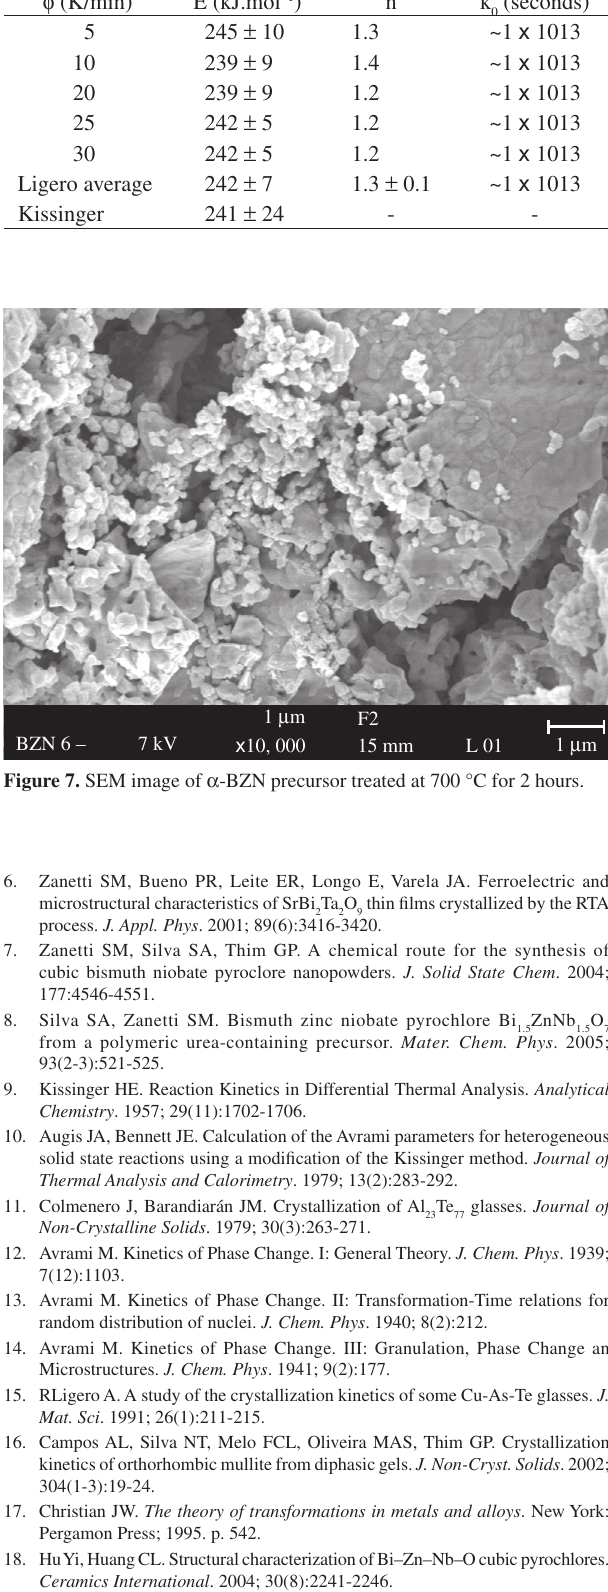
Table 1. Activation energy, the Avrami exponent, and the frequency factor obtained from each DSC curve. φ (K/min)